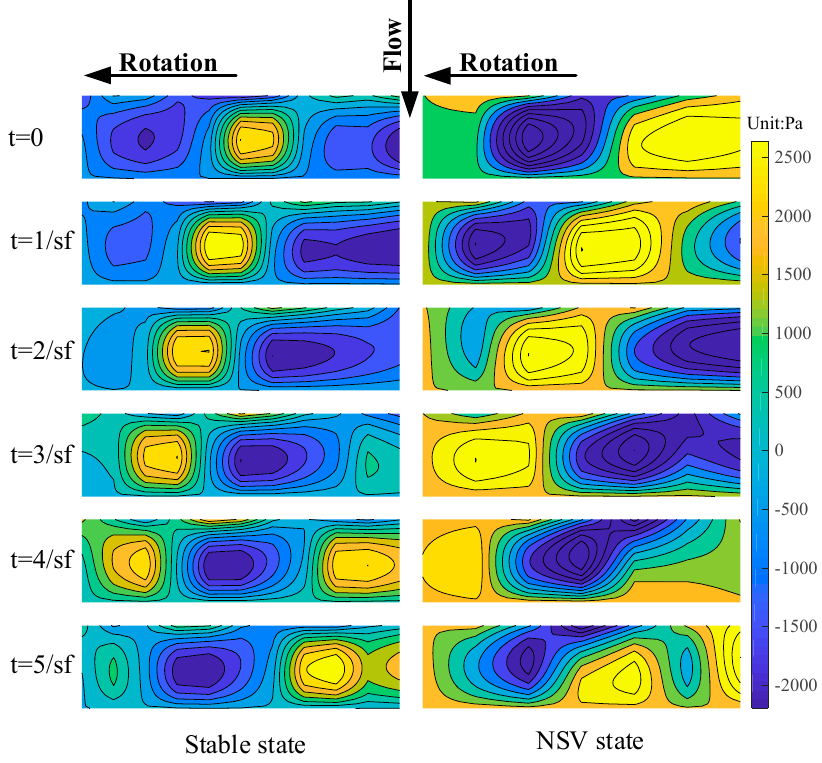
Figure 20. Dynamic pressure field comparison of stable state and NSV state.